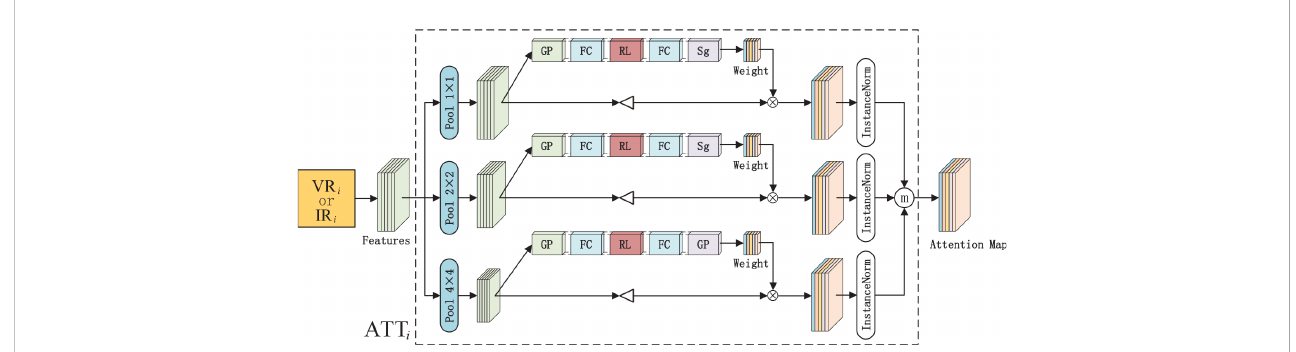
FIGURE 6 The multiscale channel attention network. The features extracted by residual network(VR i or IR i ) are fed into the ATT i to generate attention map. GP, FC, RL, SG denote the global average pooling operation, fully connected layer, ReLUfunction and sigmoid function respectively. ⊲ stands for the up-sample operation and ⨂ denotes the element-wise